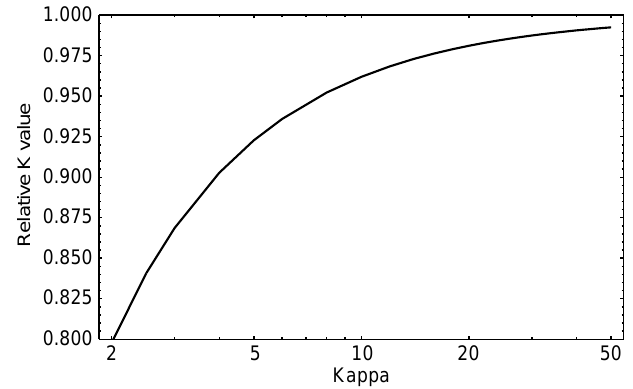
Fig. 5. Dependence of K (cid:106) = K BM on (cid:106) . Unity corresponds to the Maxwellian value. For large (cid:106) we recover the Maxwellian results as we should